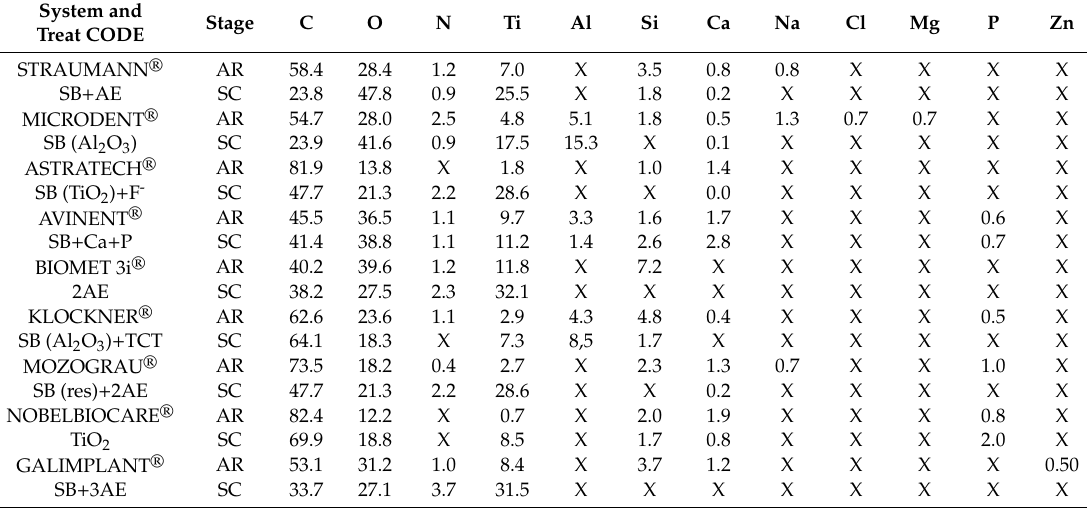
Table 4. Percentage of each element found on the implant surface, as received from the manufacturer (AR) and after receiving a sputter cleaning (SC). “X” means than the element was not found in the